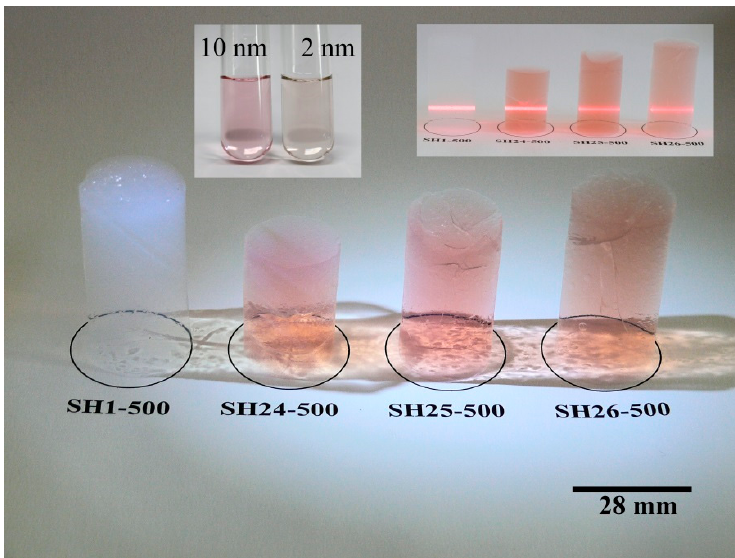
Figure 5. Photographs of native (SH1), as well as 10 nm (SH24, SH25) and 2 nm (SH26) gold nanoparticles containing monolithic silica aerogels after 500 °C/8 h of heat treatment. The top left insert shows the colors of the nanogold solutions in the same concentration as used in the aerogels. The top right insert shows the red laser light dispersion in the samples.